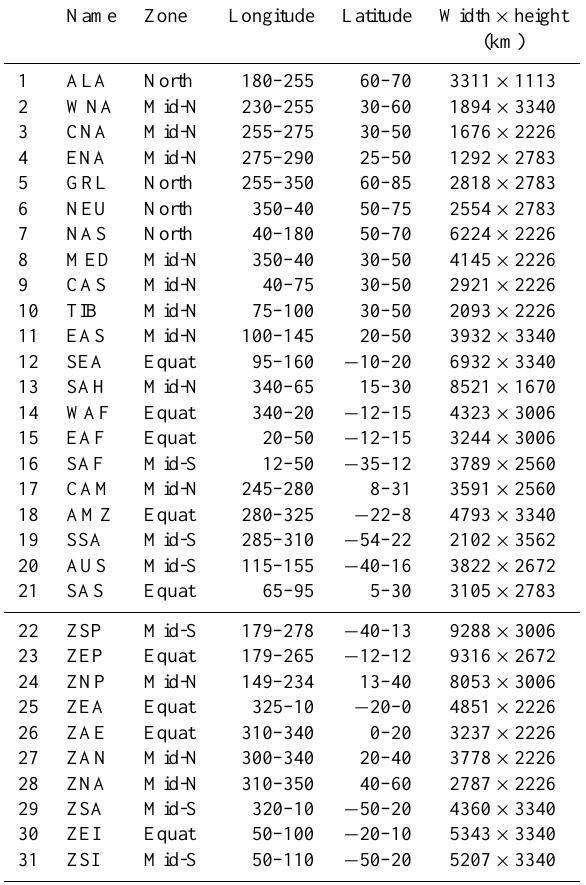
eastern North America (ENA) region in boreal winter (DJF) for the observational proxy data. The abscissa is the index, which is arranged in scan order from the western to eastern boundaries of the region. Vertical lines denote indices where the latitude jumps + 2 . 5 ◦ and longitude jumps back to the west boundary for a new scan back to the east. The increas- ing width between vertical bars is due to the triangular shape of ENA. As a result, the latitude dependence can be seen grossly across the graph, while longitude dependence ap- pears within each subsection. Clearly both temperature and precipitation decrease with latitude and, at least for south- ern strips, temperature rises with longitude (between vertical lines). Toward the north end of this region, positive